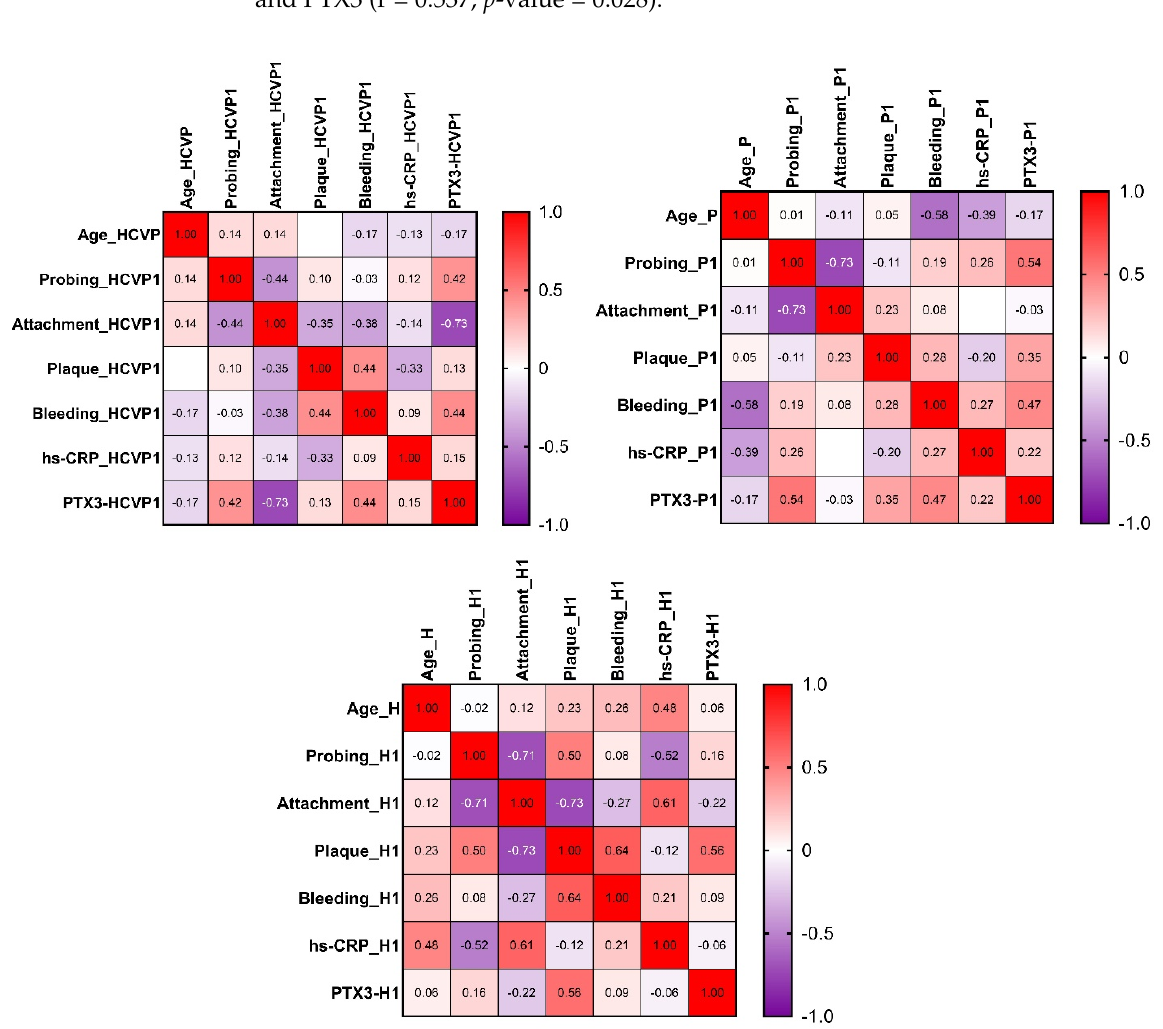
Figure 1. Heatmap of the correlation matrix for every group of patients before the treatment: HCVP1 = HCV+P group at baseline; P1 = P group at baseline; H1 = H group at baseline; hs-CRP = high-sensitivity C-reactive protein; PTX3 = pen-